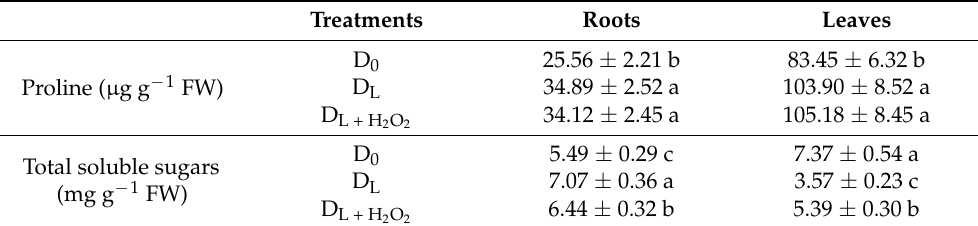
Table 5. Effects of fertigation treatments (D 0 —standard nutrient solution or control treatment, D L — raw leachate treatment and D L + H —raw leachate blended with H 2 O 2 treatment) on root and 2 O 2 leaf proline and total soluble sugar concentration in D. deremensis plants at the end of the experi- ment. The experiment simulates a cascade cropping system with different leachate treatments of Chrysalidocarpus lutescens as primary or “donor” and Dracaena deremensis as a secondary or “acceptor” plant culture. The results are expressed as means ± standard deviation ( n = 4). In each column, same letters indicate non-significant differences ( p < 0.05). Treatments Roots Leaves D 0 25.56 ± 2.21 Proline ( µ g g − 1 FW)